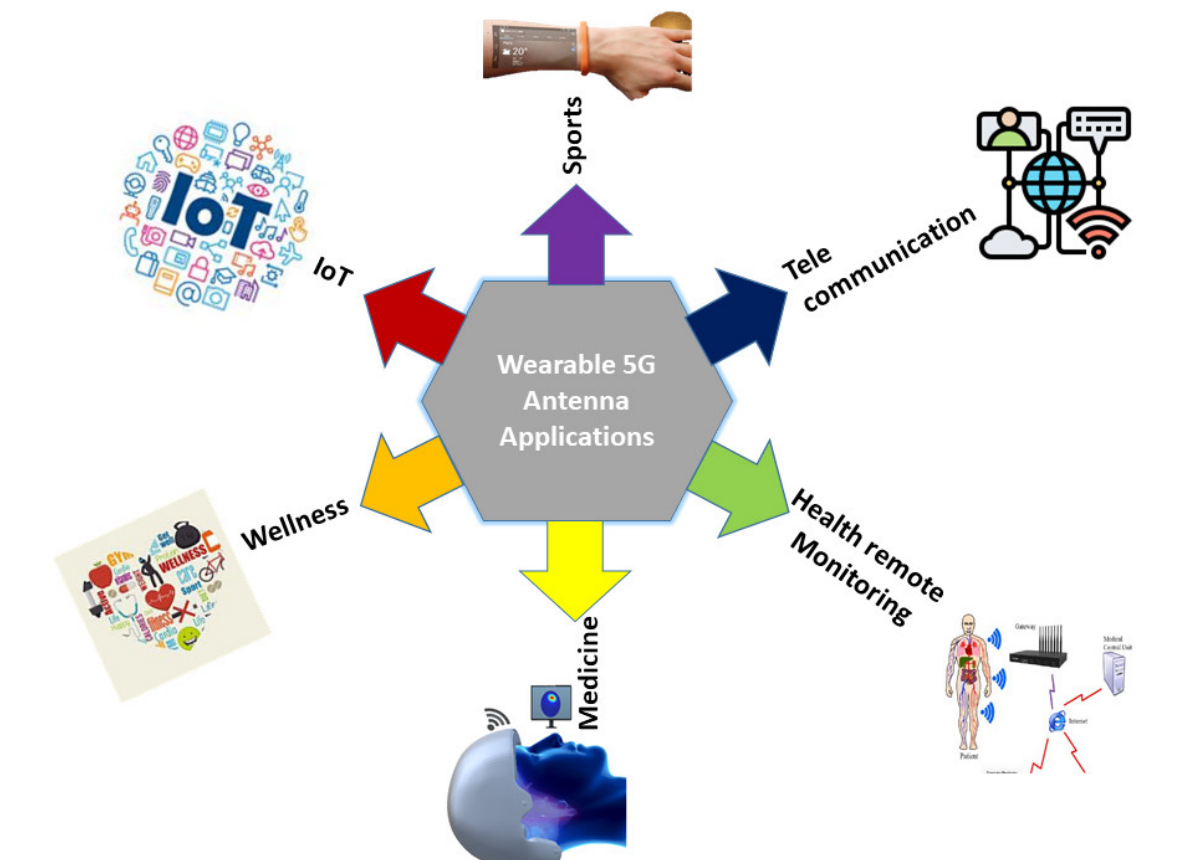
Figure 21. Illustration of wearable antenna applications.